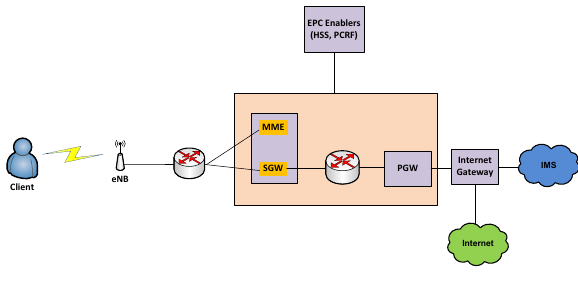
Figure 7. Implemented LTE/EPC architect OpenEPC.